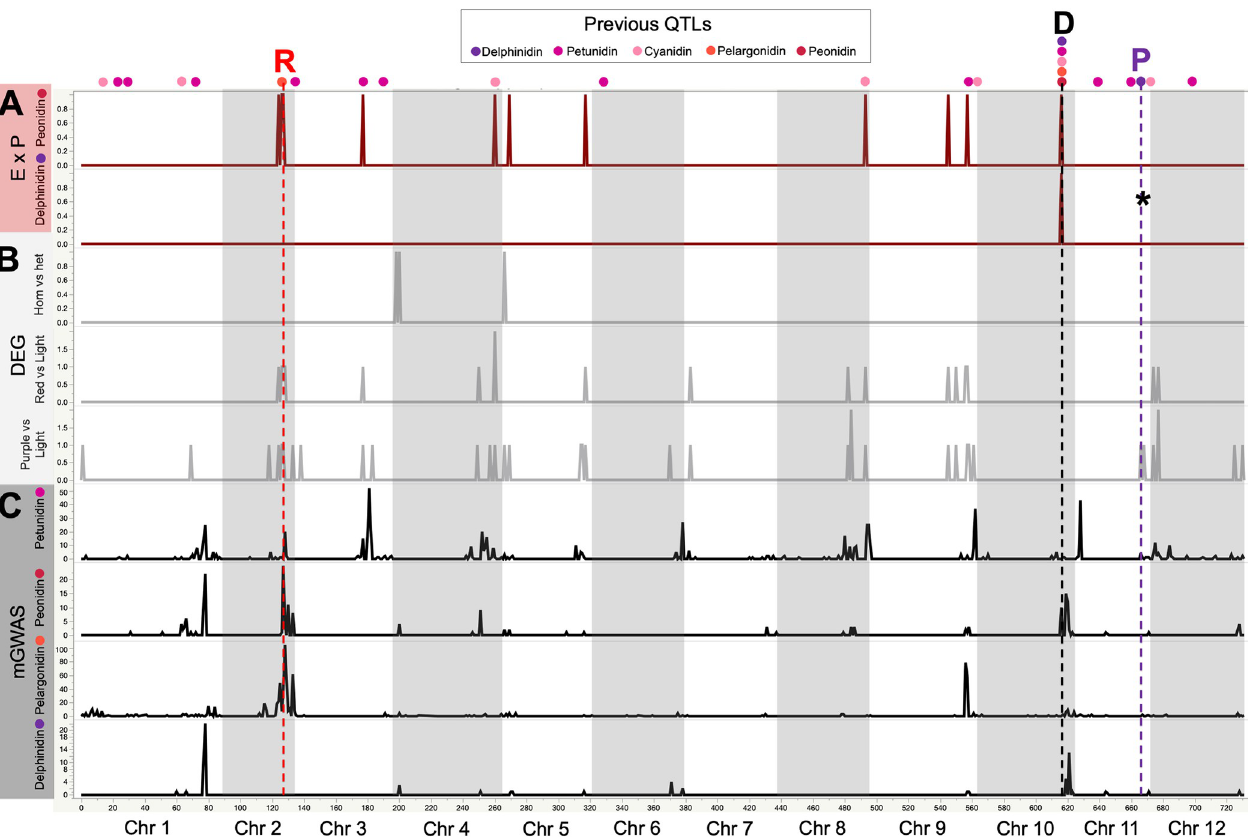
Fig 5. Genomic location of significant genes from DEG and ExM analyses. The genomic location across the potato genome v6.1 is presented in the X axis. Panels in the Y axis represent different analyses. ( A ) Generalized linear model (GLM) analyses of 4 anthocyanins based on genotypes extracted from transcriptomic data. For each anthocyanin we show the number of significant SNPs per 1MB interval; ( B ) Results of differential expression analyses. We show the number of genes with significantly different expression per 1MB interval for each of the three comparisons. ( C ) Results of Expression by Phenotype correlation analyses for two anthocyanins. We show the number of genes with a positive and significant correlation to each anthocyanin in 1MB intervals. The asterisk in the delphinidin lane indicates that the F3’5’H gene is marginally significantly correlated to delphinidin (p = 0.11). In the top of the graph, we present the location of the R , D and P loci. Dots represent the location of QTLs in a previous GWAS study by Parra et al (2019) [20] that used the same potato collection. The color of dots indicates which anthocyanin presented a QTL in the